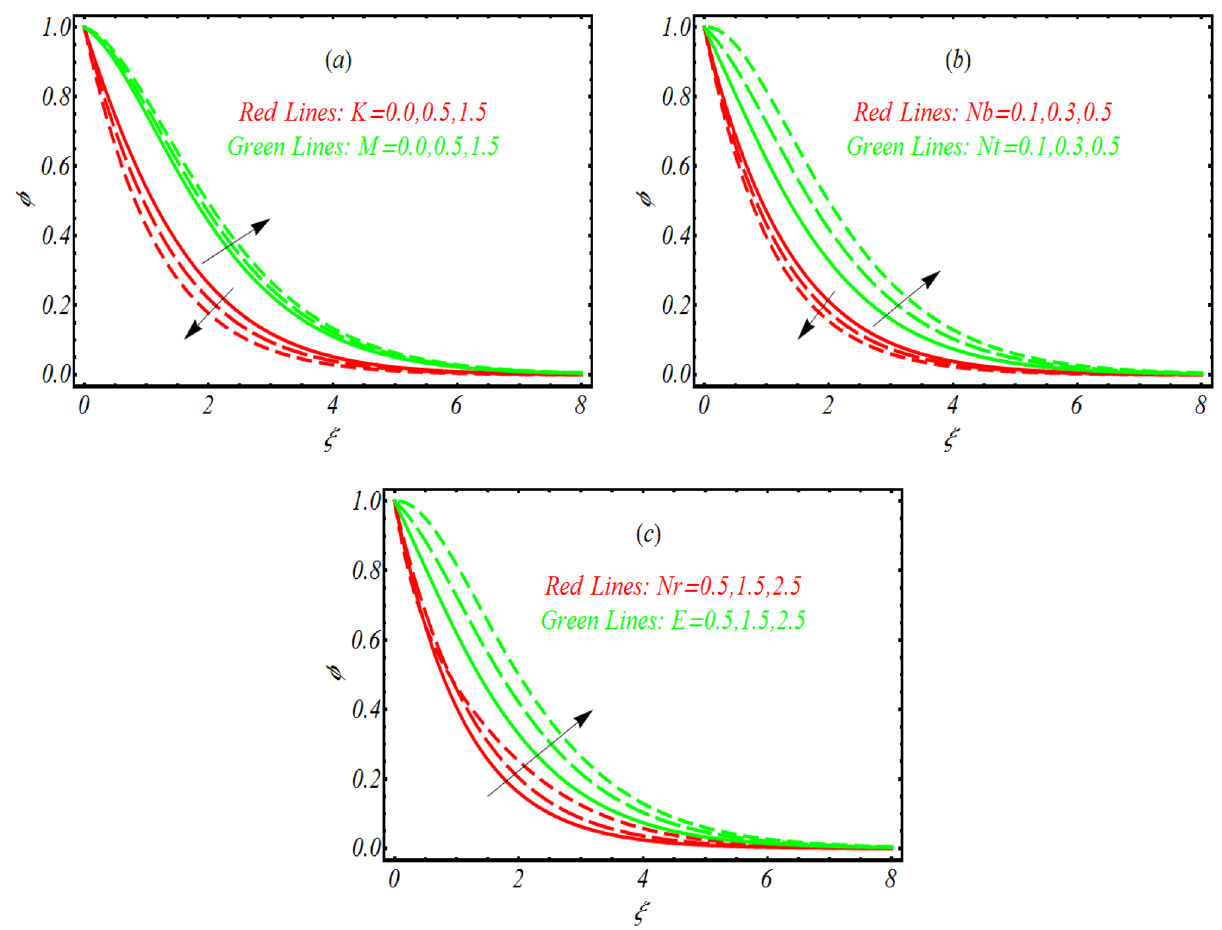
Figure 5. Variation of φ for various values of ( a ) K and M ( b ) Nt and Nb ( c ) Nr and E .